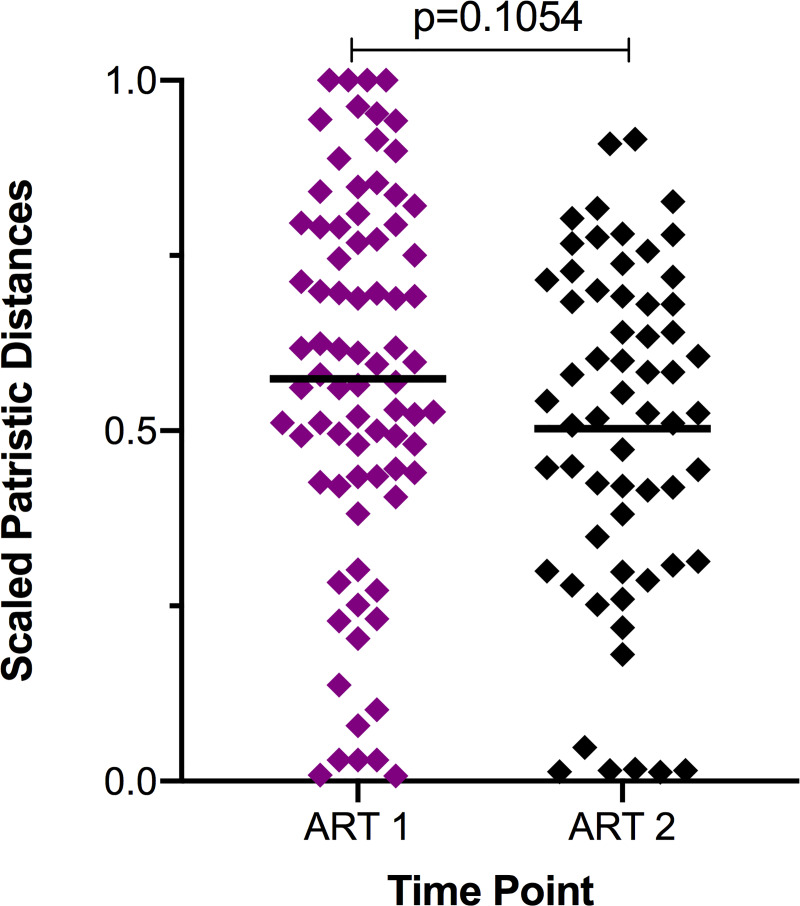
Distance from transmitted/founder (TF) virus decreases with subsequent sampling during treatment.Patristic distances from the TF virus, or root, for reservoir variants as a proportion of the greatest intrapatient patristic distance (tree height) from the maximum-likelihood phylogenetic tree; means shown in horizontal black bars. Distances are lower for variants sampled at the second time point during treatment compared to the first (unpaired t test).